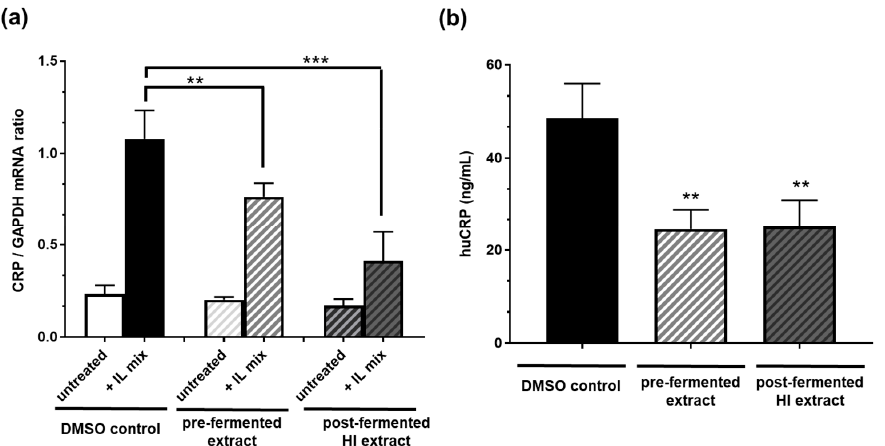
Figure 5. Soy isoflavone extracts before (pre-) and after (post-) fermentation (HI) reduced ( a ) CRP mRNA expression and ( b ) the amount of secreted CRP protein in human hepatoma (Hep B3) cells. Cells were incubated with either pre- or post-fermented extract (10 μ g/mL) solved in DMSO. CRP expression was stimulated with 400 U/mL interleukin-1ß and 200 U/mL interleukin-6 (IL Mix). DMSO only served as solvent control. n = 6 independent experiments. Results are mean values ± SD. Error bars indicate standard deviation. *** p < 0.001; ** p < 0.01: unpaired t-test (mRNA) or Mann–Whitney test (secreted protein level) between treatment compared to DMSO solvent control after stimulation.